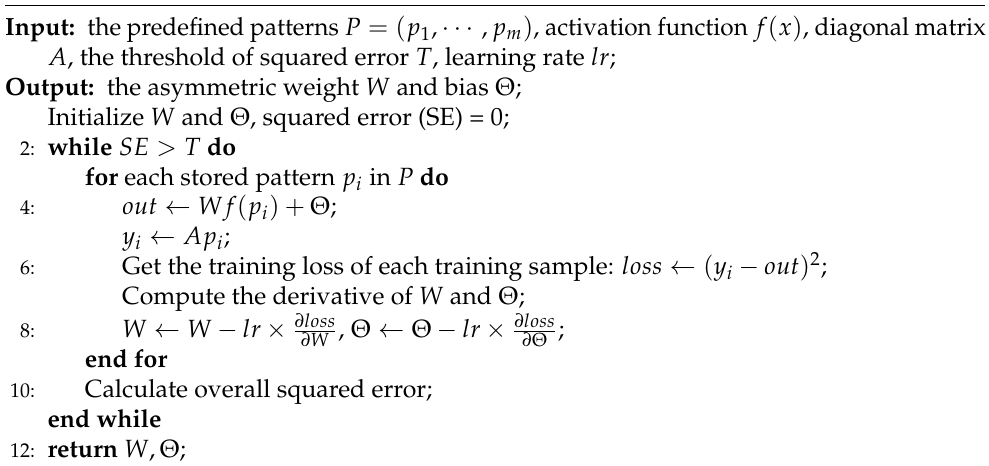
Algorithm 2 Training process of